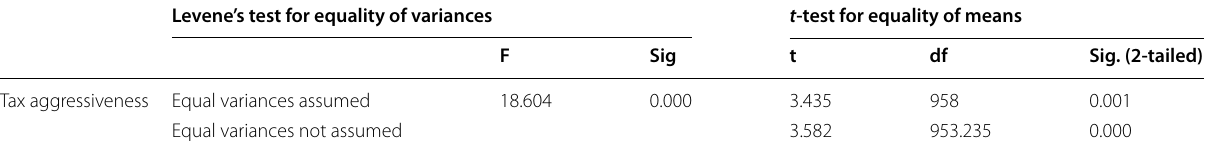
Table 5 Independent t-test for difference in tax aggressiveness. Source : Researcher’s compilation (2022) Levene’s test for equality of